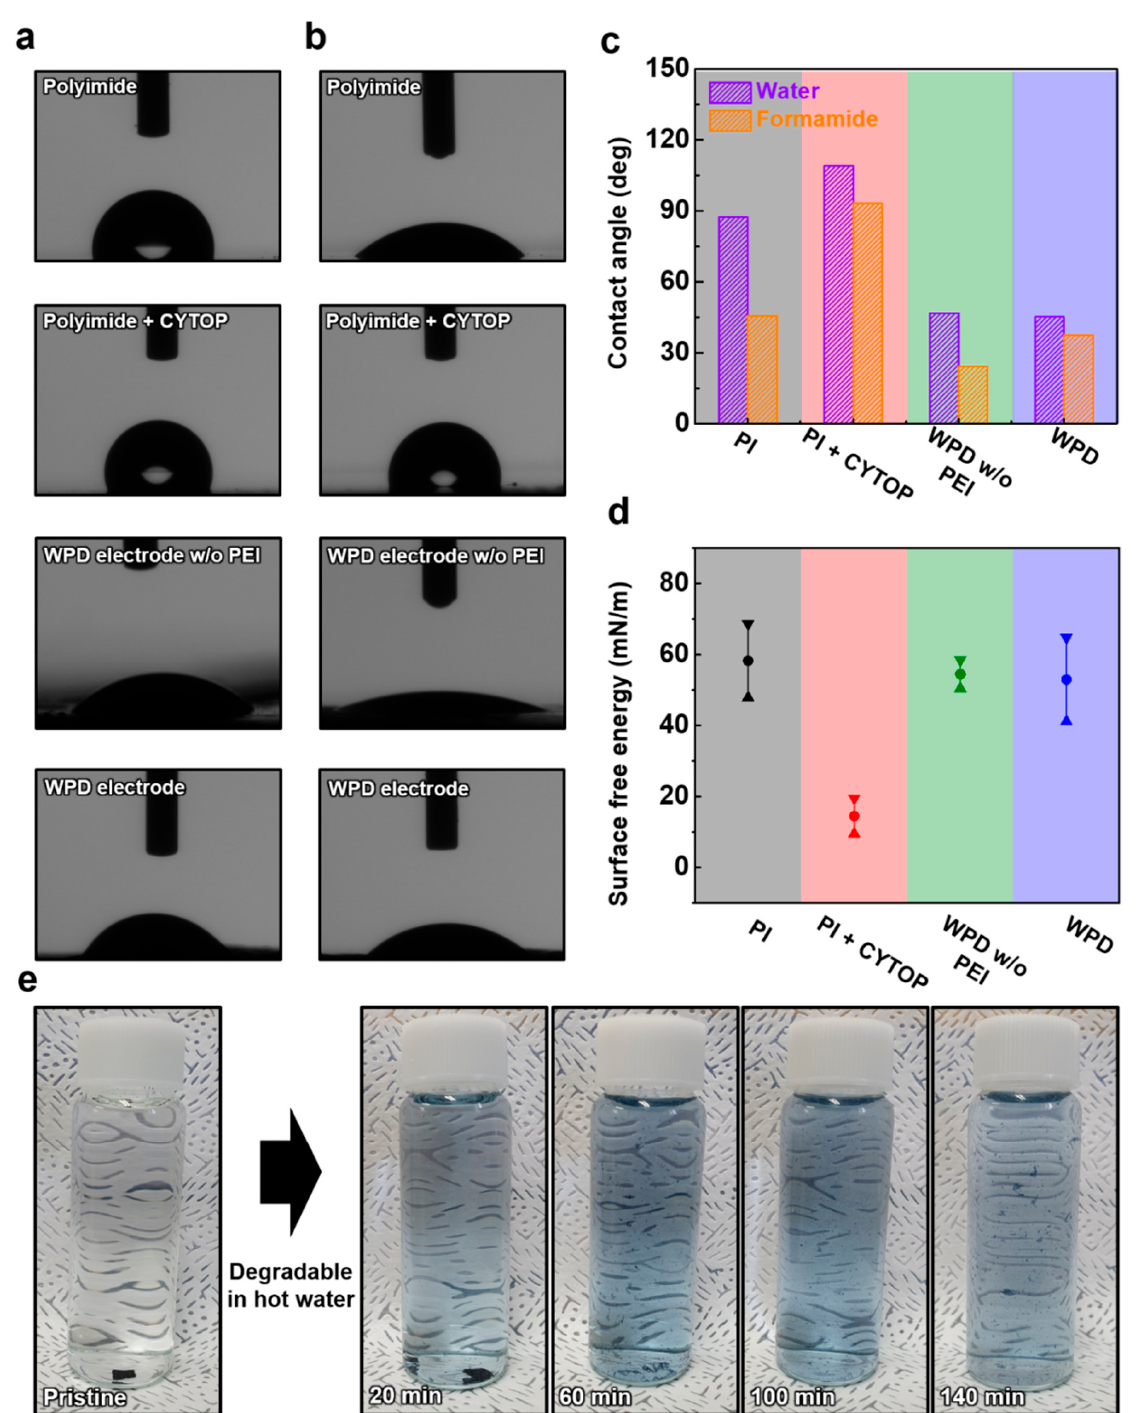
Figure 5. The analysis of contact angle. ( a ) The image of contact angle with deionized water; ( b ) the image of contact angle with formamide; ( c ) the histogram graph of contact angle with deionized water and formamide; ( d ) the graph of surface energy; ( e ) photography of degraded the WPD electrode over time.